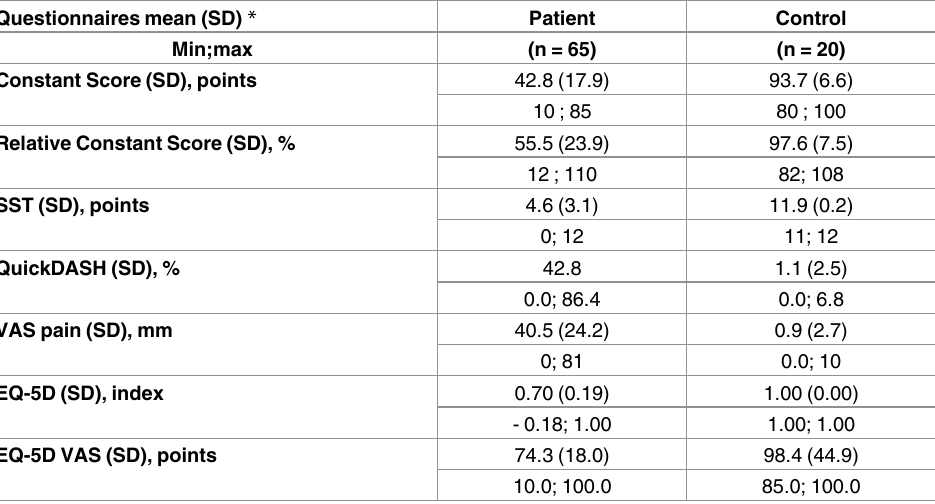
Table 4. Clinical questionnaires results. Questionnaires mean (SD)